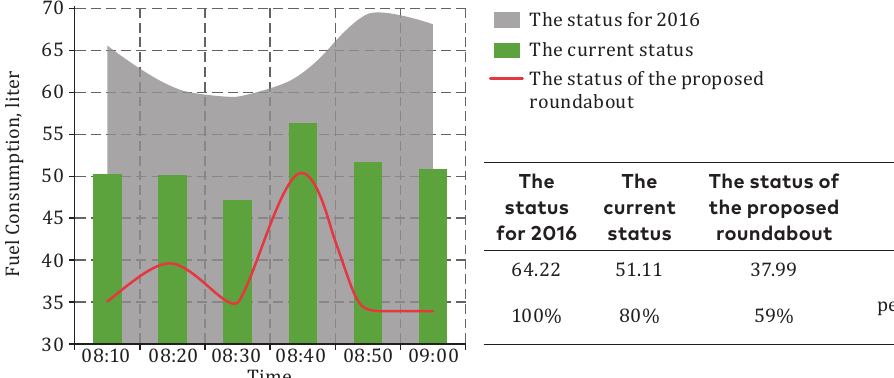
Figure 22. Fuel consumption of vehicle-time change